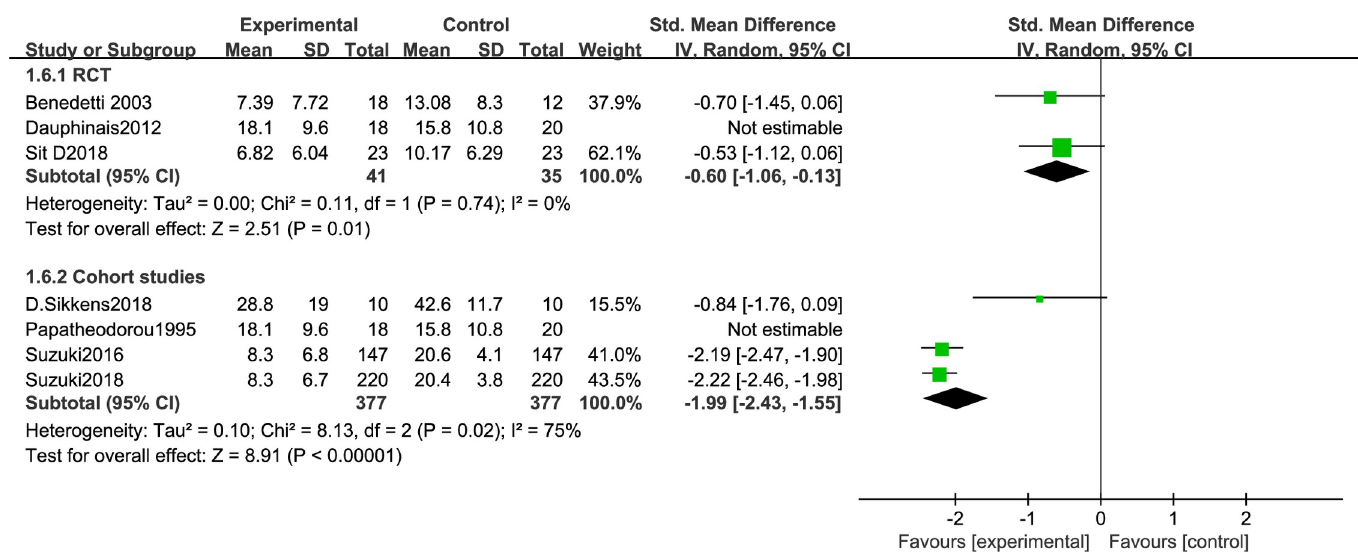
Fig 15. Forest plots with without psychotropic